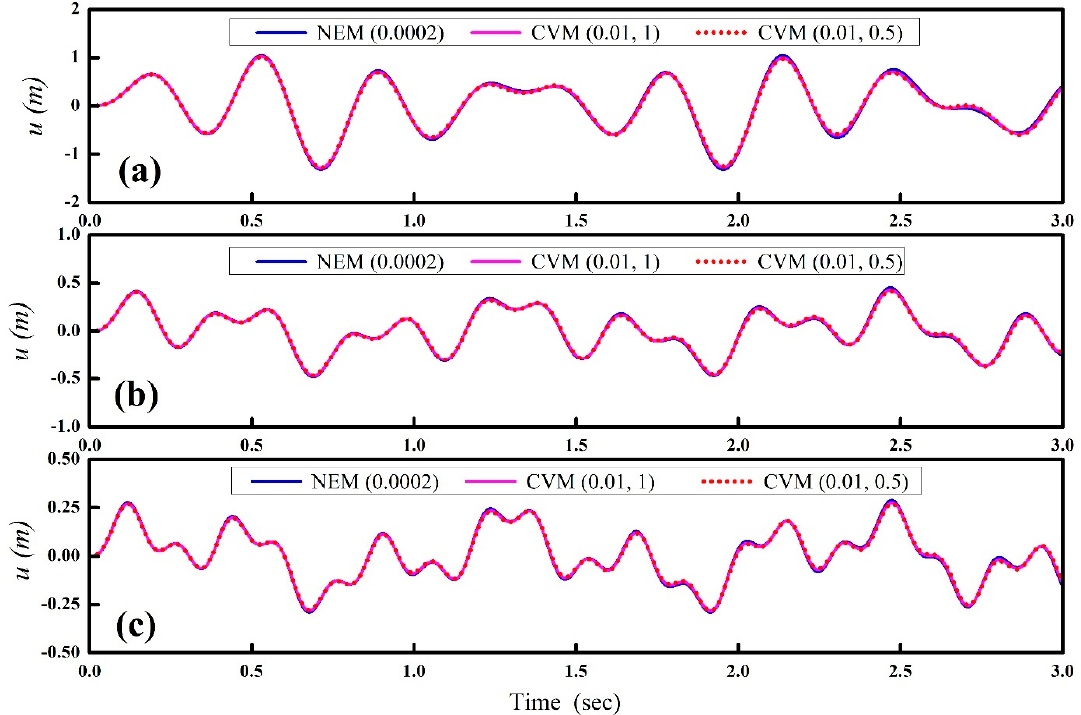
Figure 17. Forced vibration bottom-storey responses of the eight-storey building for SS with different A values ( a ) 20; ( b ) 30 and ( c ) 40.